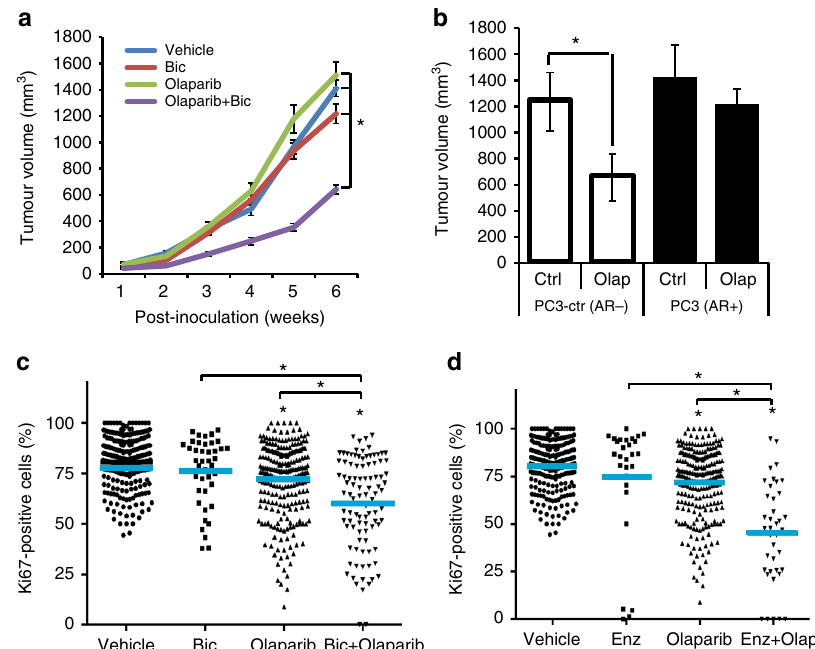
Fig. 4 Dual inhibition of AR and PARP1/2 function represses PCa growth. a Tumour xenografts of C4-2 cells. NSG mice were treated with DMSO (vehicle) or bicalutamide and/or Olaparib for 6 weeks, statistical signi fi cance calculated using two-way ANOVA. b Tumour xenografts of PC3-ctl or PC3-AR cells, NSG mice were administered with DMSO (vehicle) or Olaparib as indicated, P -value by two-sided Student ’ s t -test. c , d Quanti fi cation of ki67 expression in ex vivo culture of human PCa treated with ( c ) bicalutamide (10 μ M) or ( d ) Enzalutamide (10 μ M) and/or Olaparib (2 μ M) for 72 h, signi fi cance